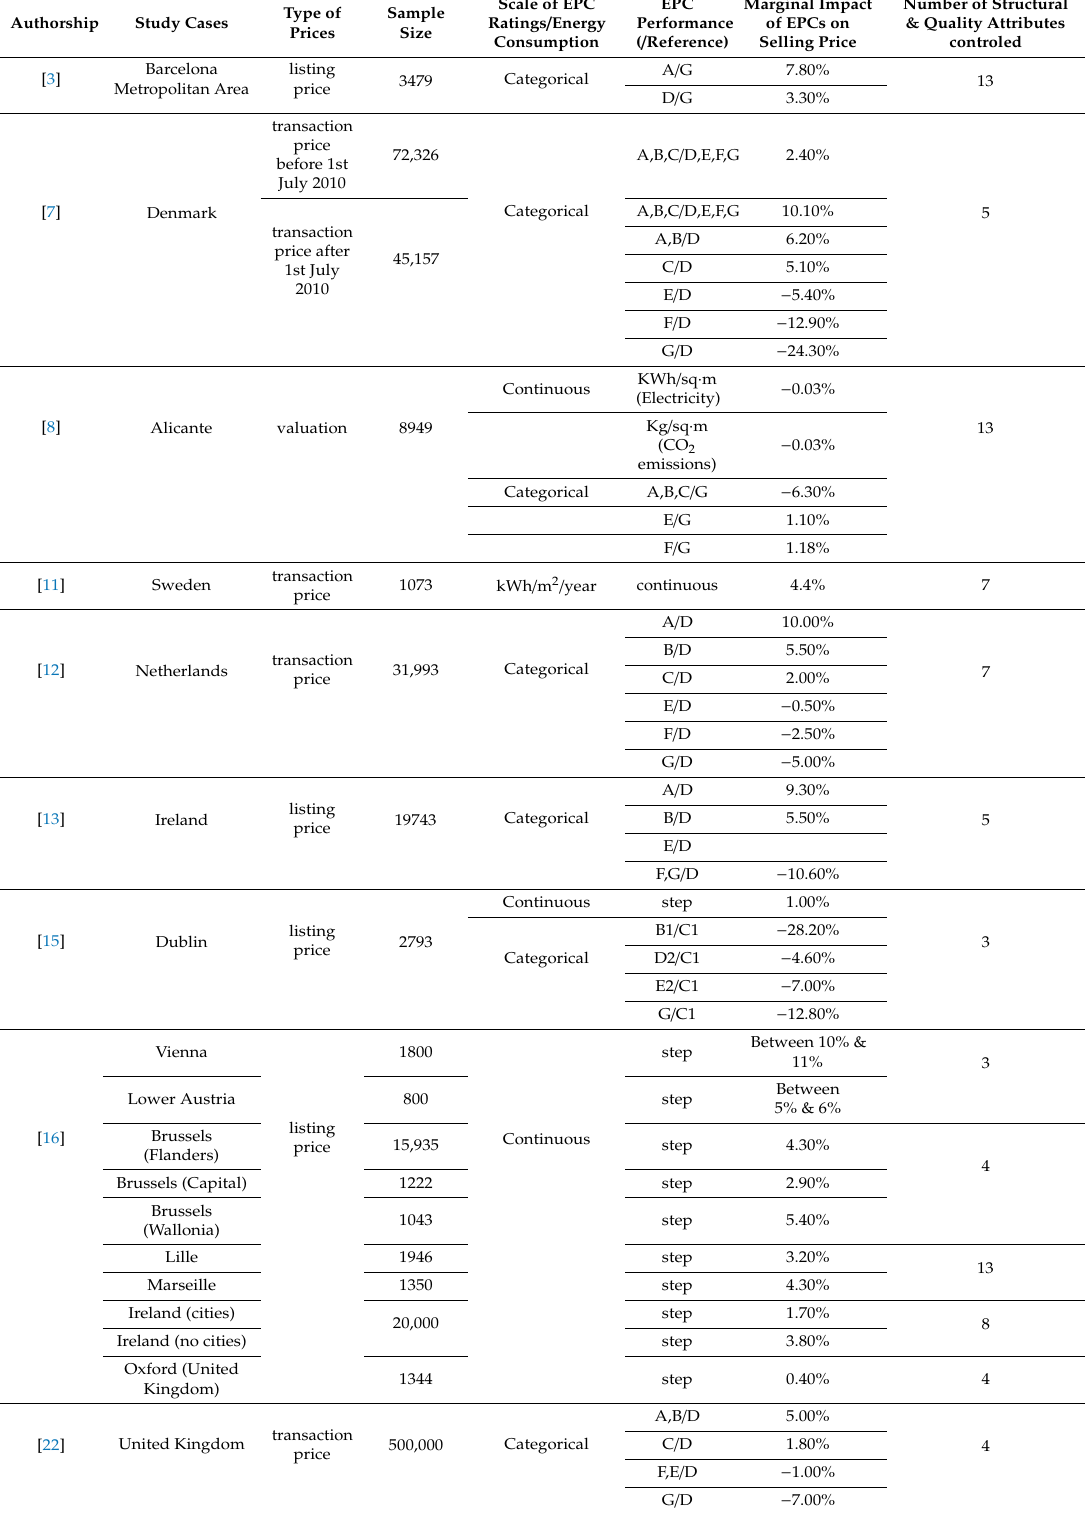
Table 1. Selected studies on EPC ratings marginal